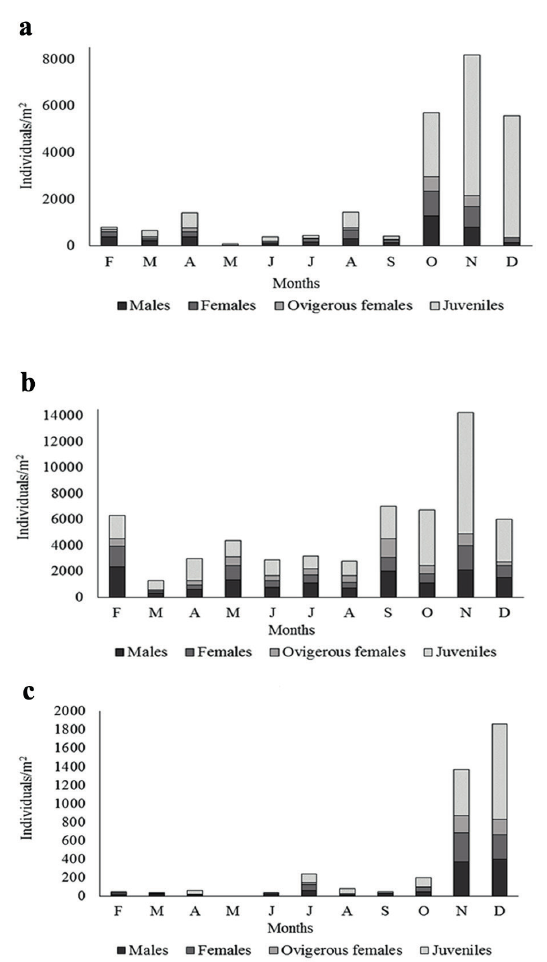
Figure 4 - Monthly mean density of males, females, ovigerous females and juveniles of H. pampeana at site 1 ( a ), site 2 ( b ) and site 3 ( c